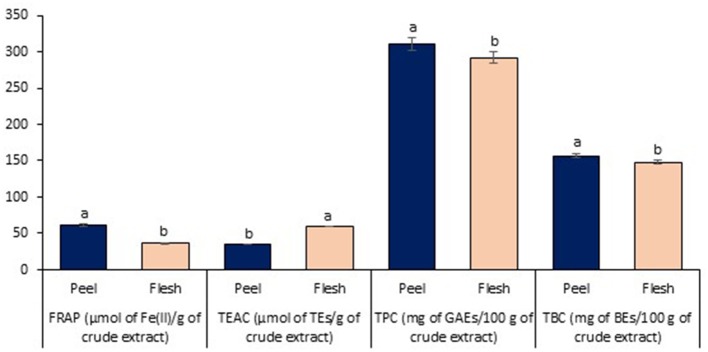
Antioxidant properties assessment of peel and flesh extract of red-purple pitaya obtained from the optimized LBEPS. Values are mean ± SD of triplicate readings. Different letter(s) represent a significant difference (p < 0.05) using Tukey's test within FRAP, TEAC, TPC, and TBC.